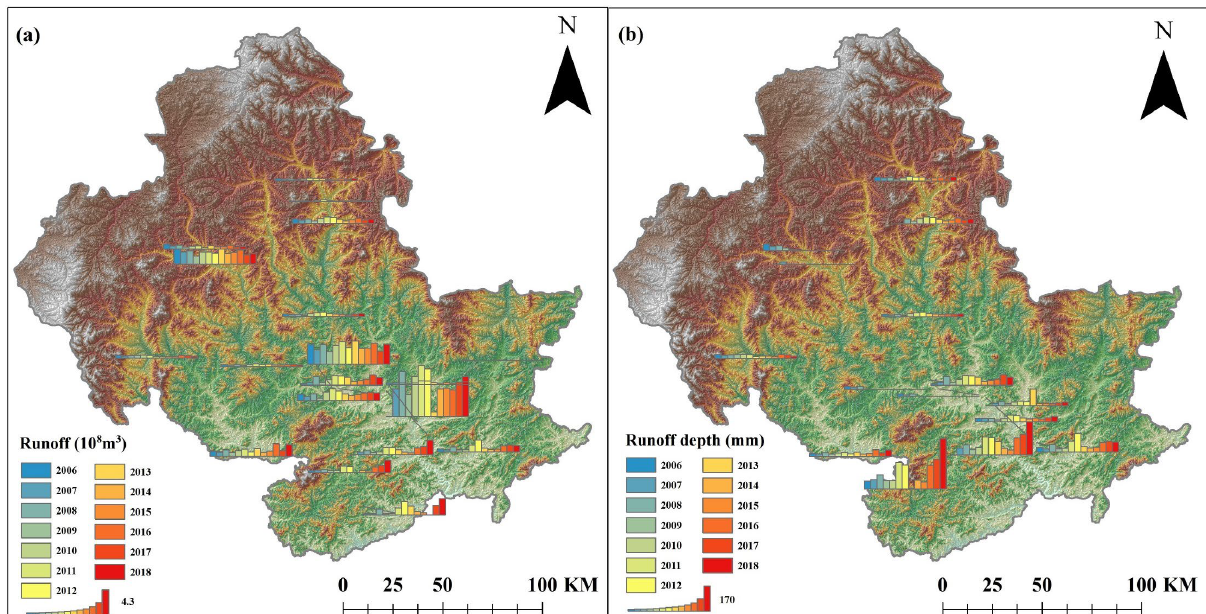
Figure 3. Annual spatial distribution of runoff and runoff depth. ( a , b ) were the spatial distribution for annual runoff and annual runoff depth, respectively.